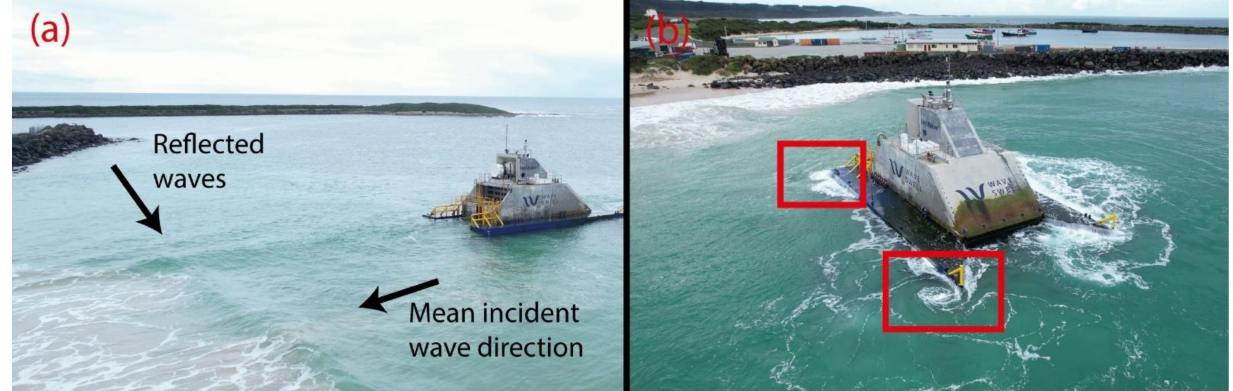
Figure 12. ( a ) Aerial photograph on 22 July 2021 showing reflected waves from the Grassy Harbour breakwater propagating towards the OWC WEC. ( b ) Aerial photograph on 22 July 2021 showing vortex formation at the corners of the OWC WEC